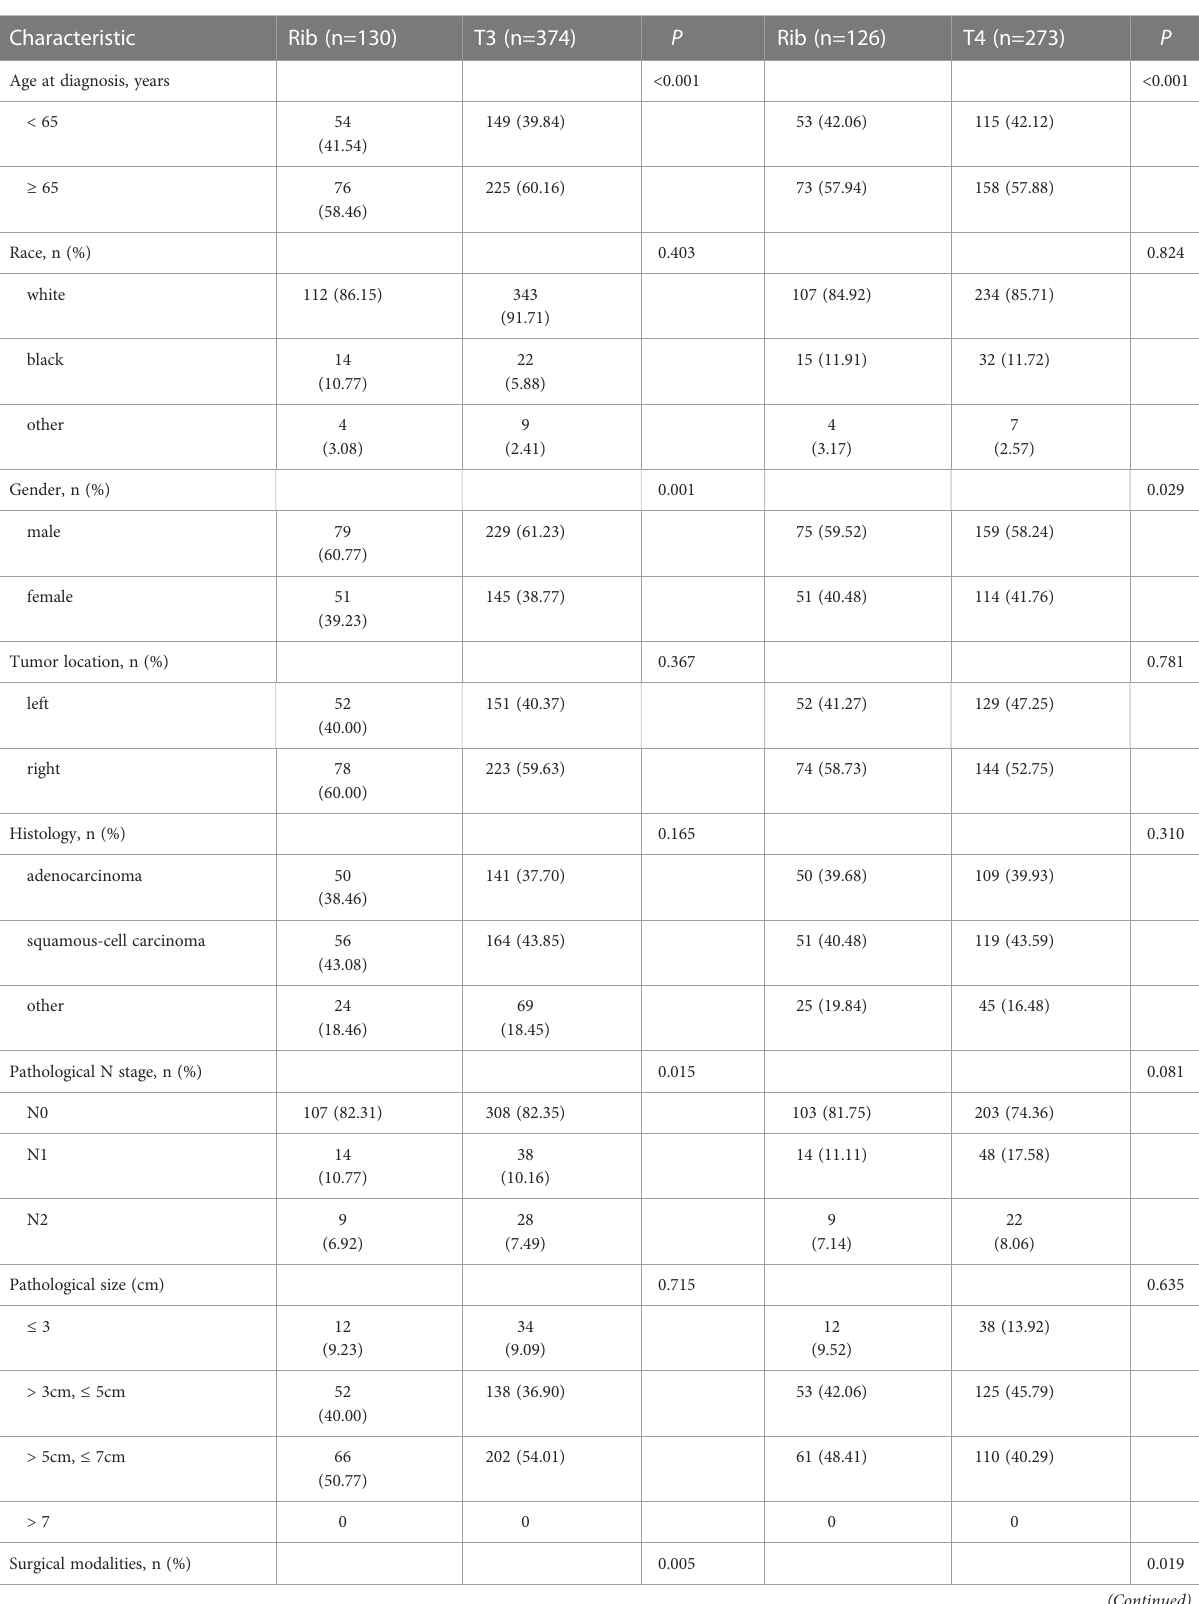
TABLE 4 Baseline characteristics for patients with rib invasion in the matched